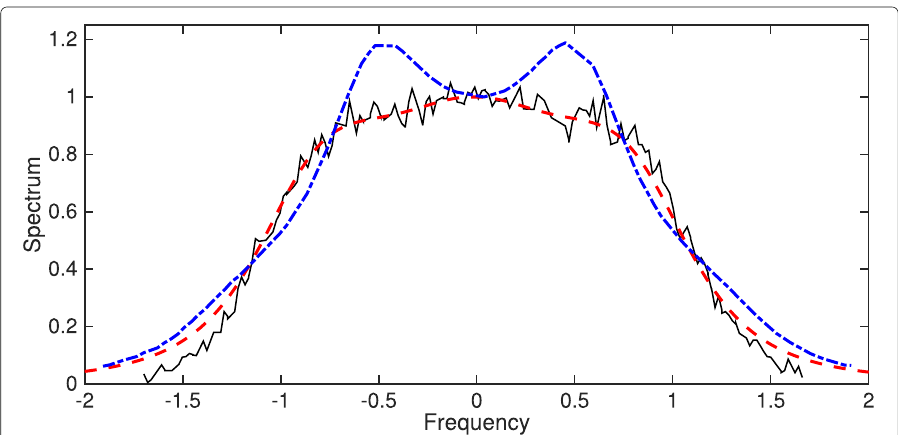
Fig. 8 Comparisons in the spectra of spontaneous RBS between the experimental data (the solid line) from Ref. [25], the LBE (the dashed line) for polyatomic gas [80], and the rational extended thermodynamics with 14 moments (the dash-dotted line) by Ruggeri and Sugiyama [54]. The light is scattered from CO 2 when Kn = 0.1114. Note that the frequency is normalized by 1.06 GHz, and the shown spectra are the convolution of S s ( Kn , f s ) and the Lorentzian function Lor ( f s ) with the Full Width at Half Maximum being 210 MHz, i.e., Lor ( f s ) ∝ 1 /( f 2 s + 9.8 × 10 − 3